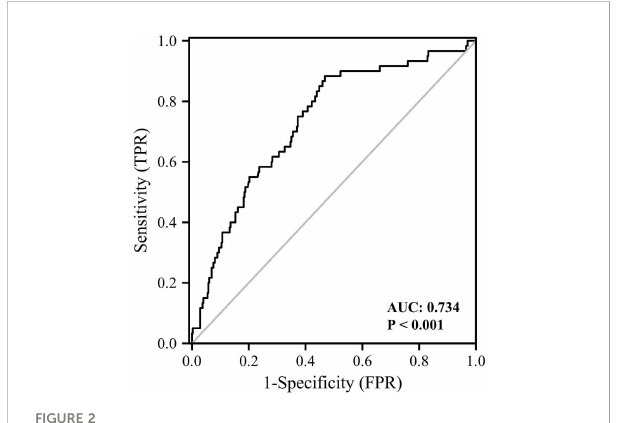
FIGURE 2 ROC curve analysis of the ability of plasma GPNMB to predict the presence of diabetes. AUC, area under curve.